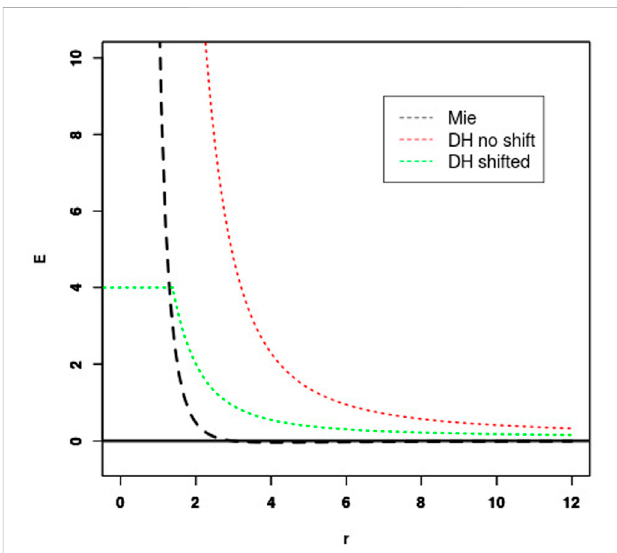
FIGURE 1 Fitting Debye-Hückel (DH) energy to Mie potential. The shift of the unshifted DH potential (red) is set so that the Mie (black) and shifted DH potential (green) cross for some energy threshold (4 kcal/mol in this